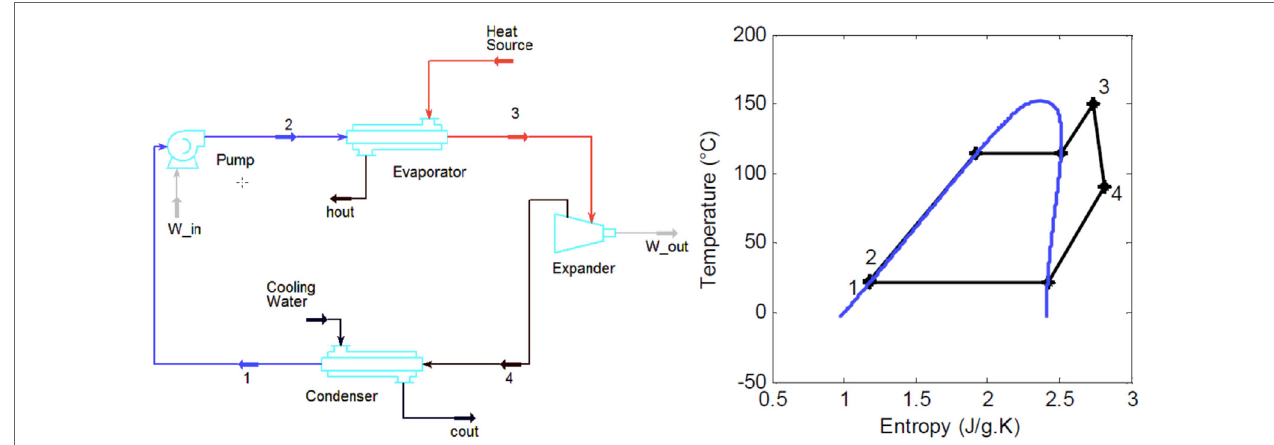
FiGURe 3 | Typical sub-critical non-regenerative ORC system layout and cycle on a T – S diagram with pure R-245fa as the working fluid